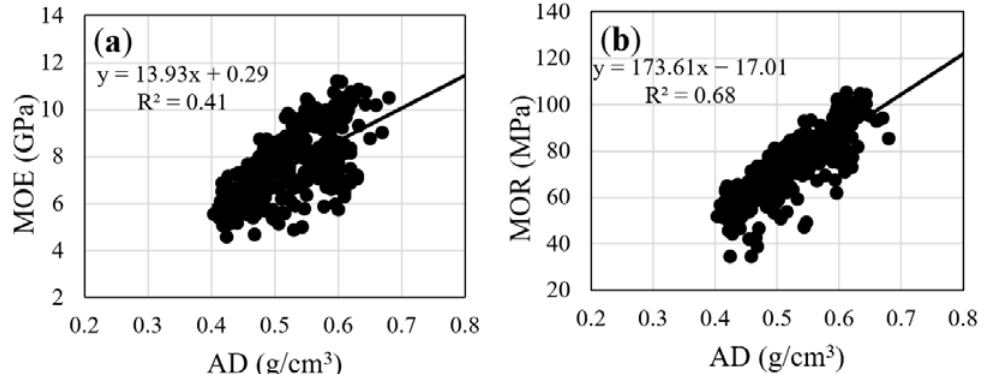
Figure 5. Relationship between air-dry density (SWV S ) and static properties: ( a ) modulus of elasticity (MOE) and ( b ) modulus of rupture (MOR) for all clones.